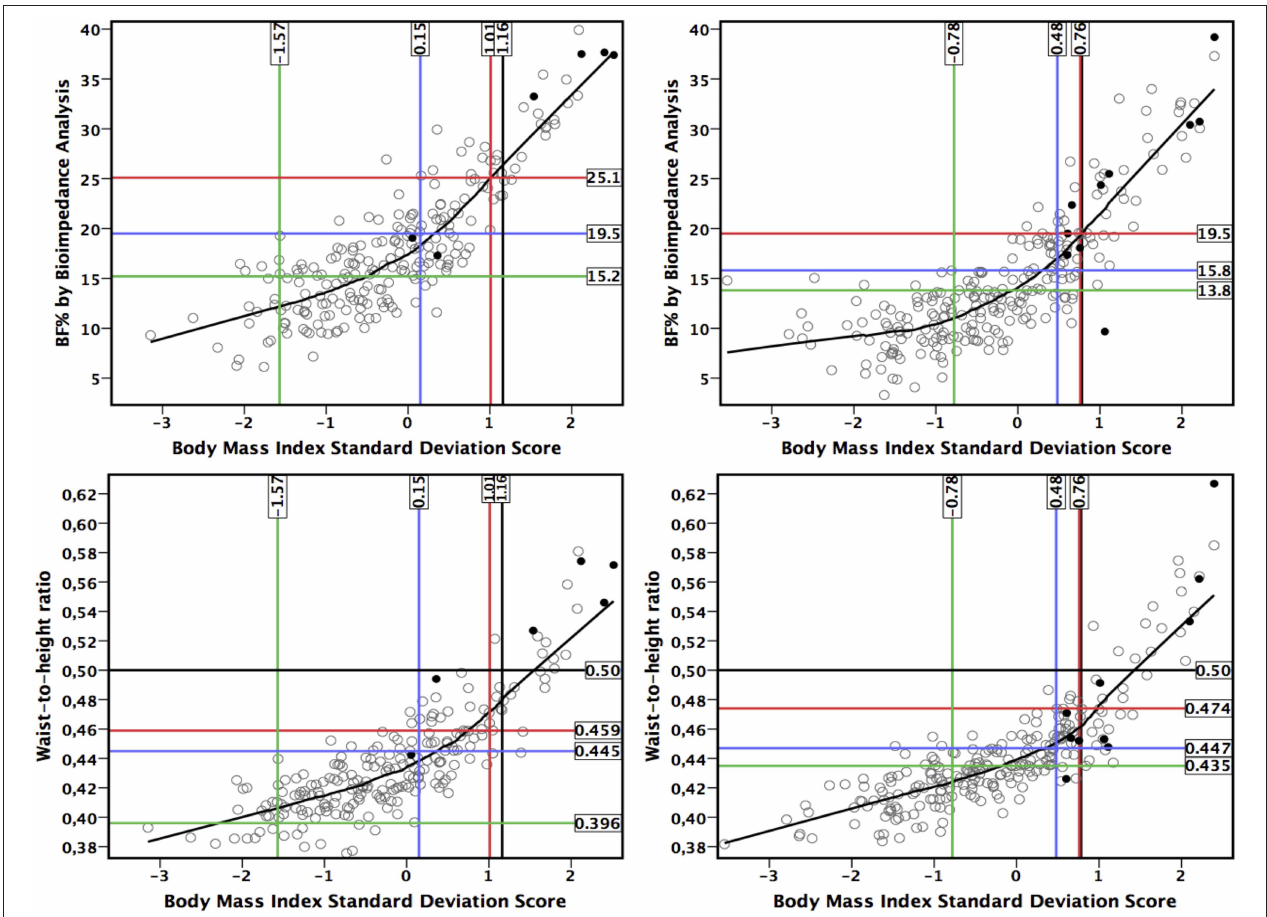
FIGURE 4 | Association between body mass index standard deviation score, waist-to-height ratio and body fat percentage (BF%) by bioimpedance analysis in girls (Left) and in boys (Right) . Black dots represent children with metabolic syndrome ( 33). Vertical and horizontal lines represents: point where sensitivity equals with specificity (blue line), threshold by negative likelihood ratio ( < 0.20) (red line), threshold by positive likelihood ratio ( > 5) (green line), and the traditional national criteria ( 30) (black